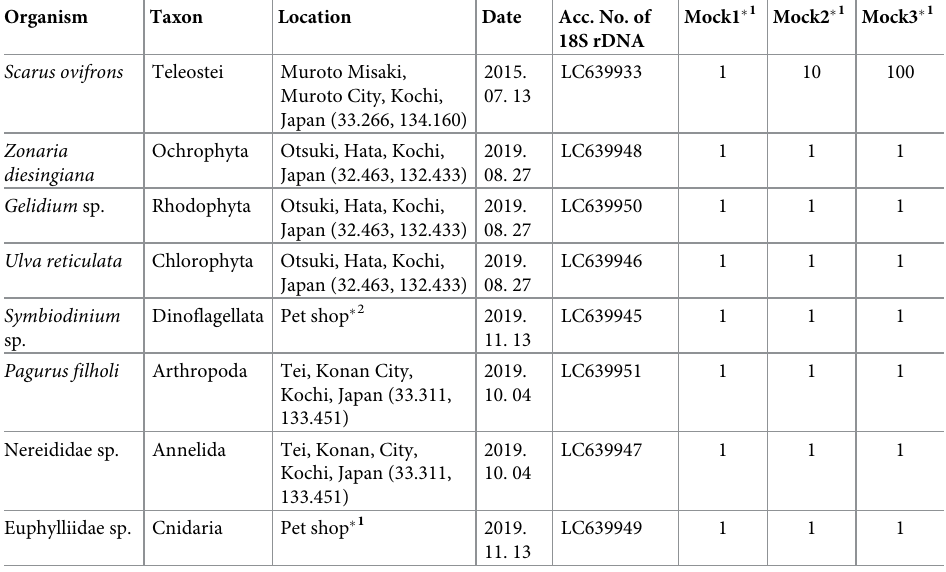
Table 2. Details of the experimental design and the organisms used to create the three mock community samples (Mock1–3) used for the metabarcoding.